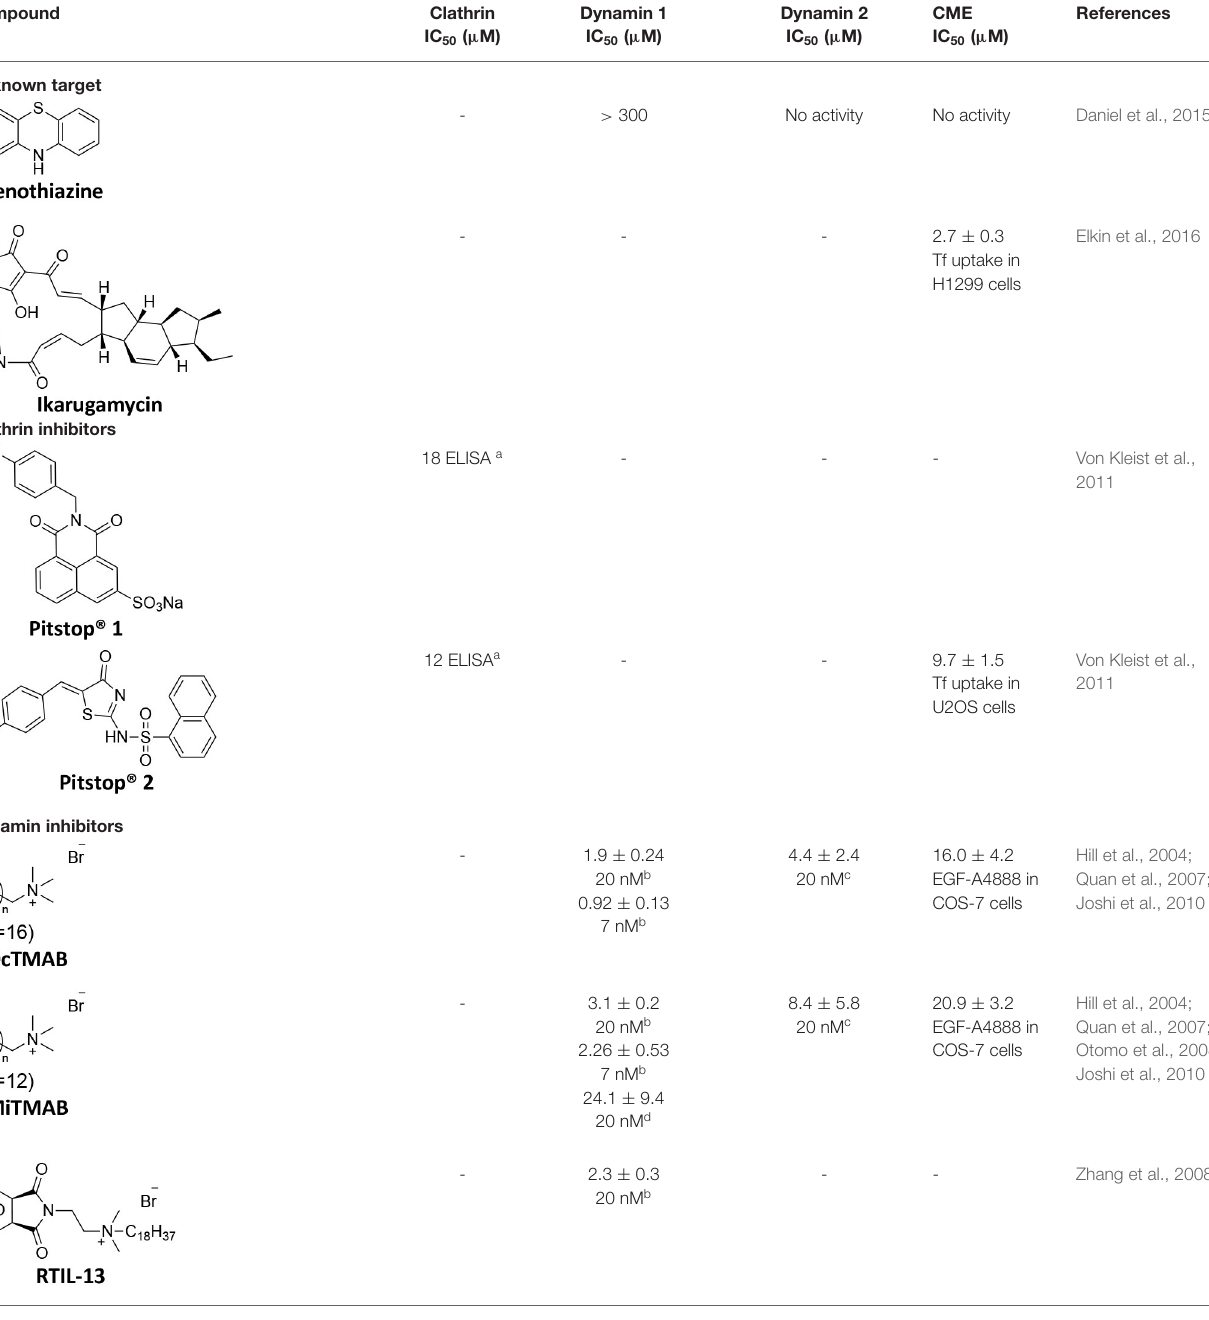
TABLE 2 | IC 50 of compounds discussed in this review.